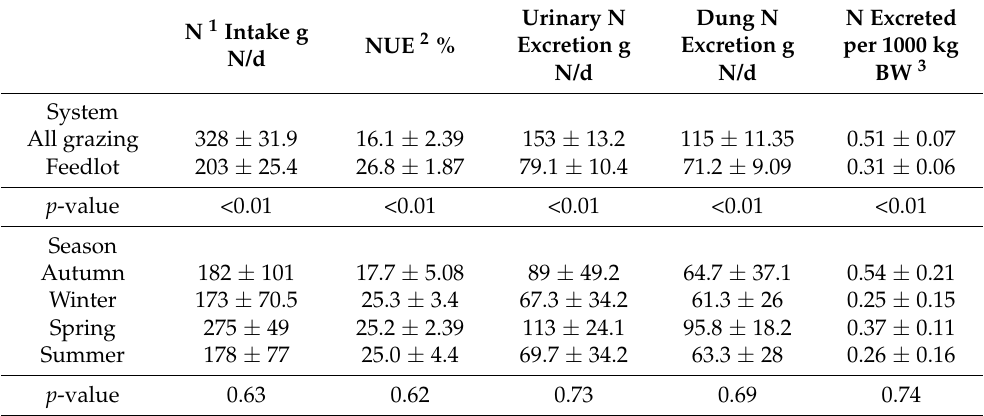
Table 6. Effect on system and season on nitrogen partitioning (mean ± standard error) of Chilean beef